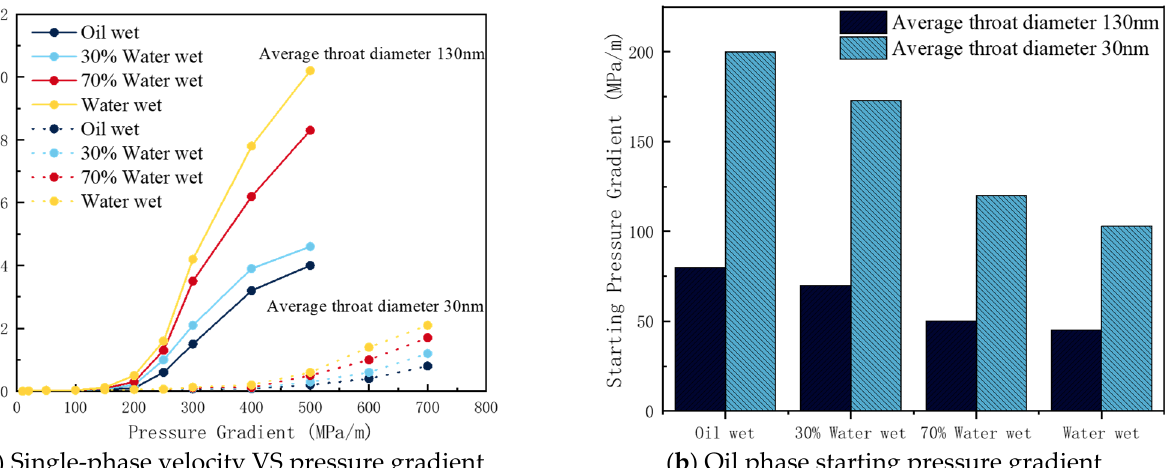
Figure 15. Oil pressure diagram of hydrophilic minerals with different proportions.